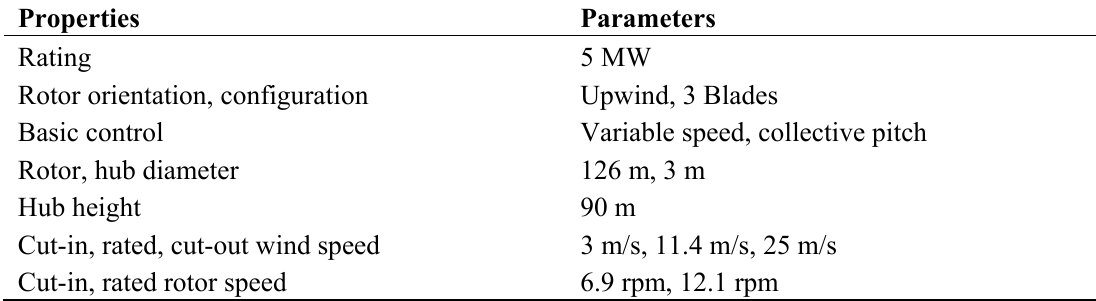
Table 1. Main characteristics of UpWind/5 MW offshore reference turbine model